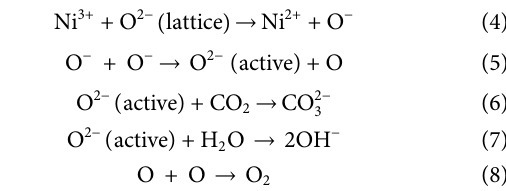
Frontiers in Energy Research |